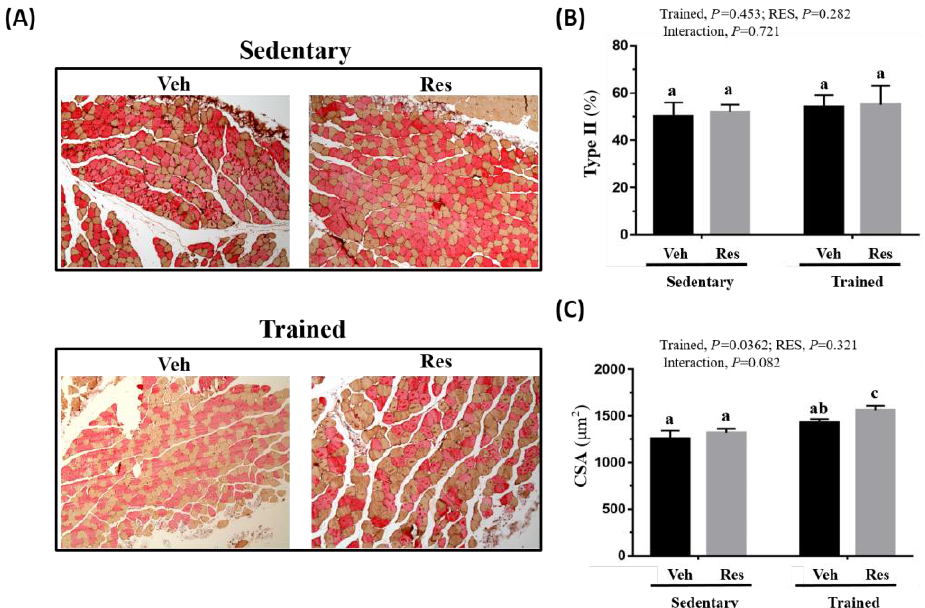
Figure 8. Effect of climb training (Trained) and/or resveratrol (RES) supplementation on the muscle of thigh with IHC staining ( A ), muscular type proportions ( B ), and cross section area (CSA) ( C ). Specimens were photographed under a light microscope. (Hematoxylin and eosin stain, magnification: 200 × ; scale bar, 40 µ m). Bars with different superscript letters (a, b, c) are significantly different at P < 0.05. The abbreviations Veh and RES represented the vehicle and resveratrol supplement, respectively.